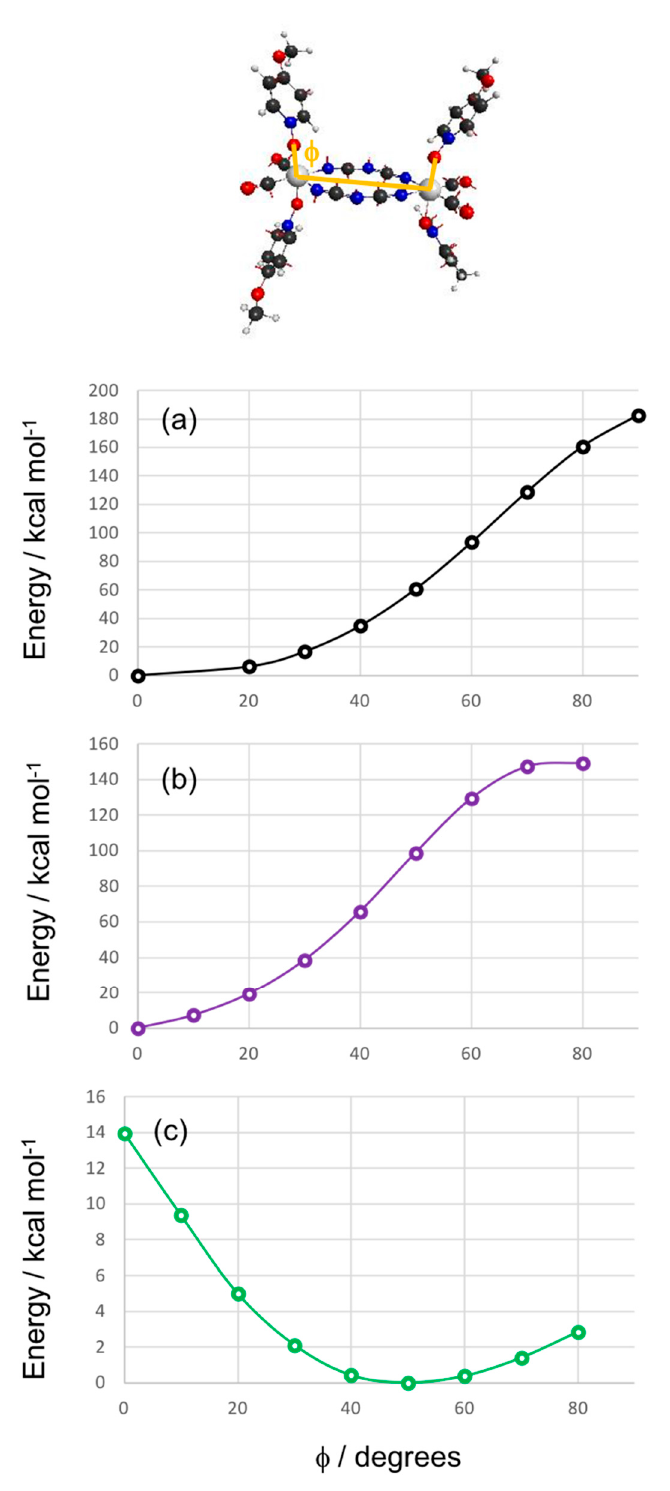
Figure 10. Potential energy profiles along the ϕ dihedral angle, which is defined at the top of the structure of ( a ) Mn(II), ( b ) Co(II), and ( c ) Cd(II) complexes of 2 , 1 , and 3 , respectively.